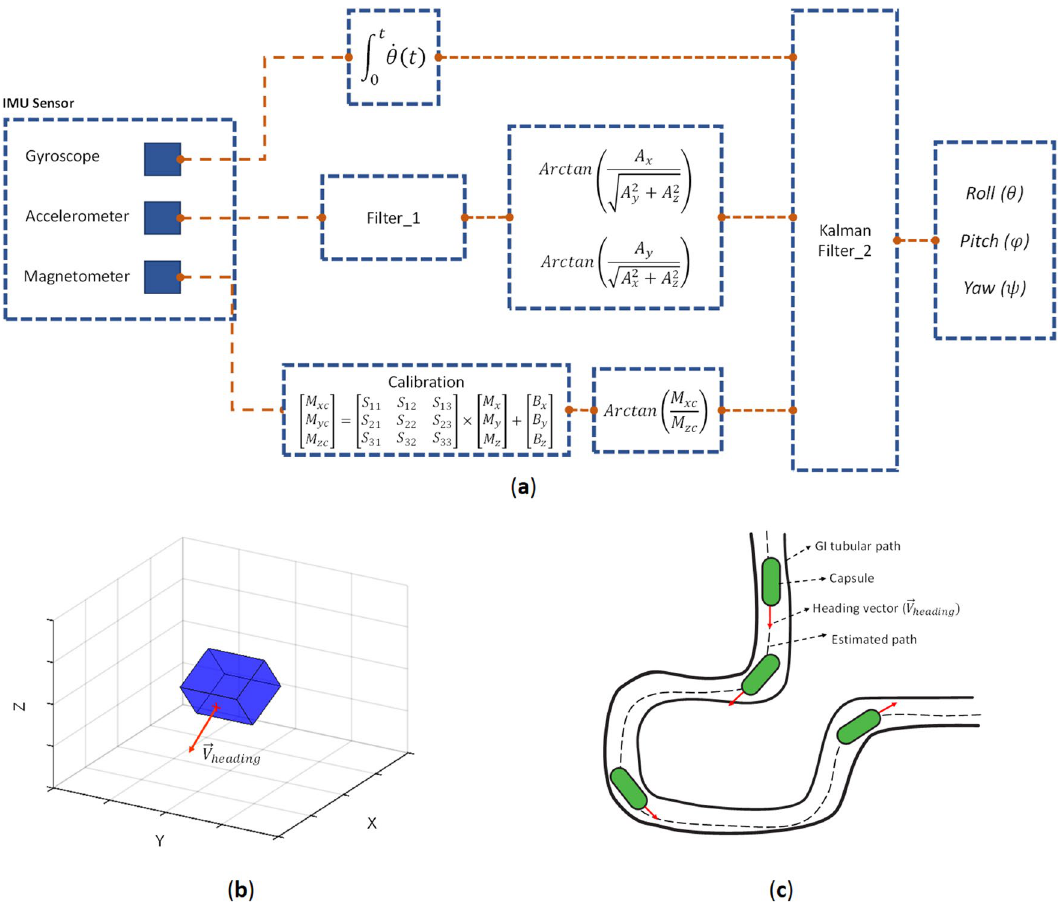
Figure 6. ( a ) IMU sensor fusing schematic, ( b ) 3D orientation result and ( c ) overview of the fusion